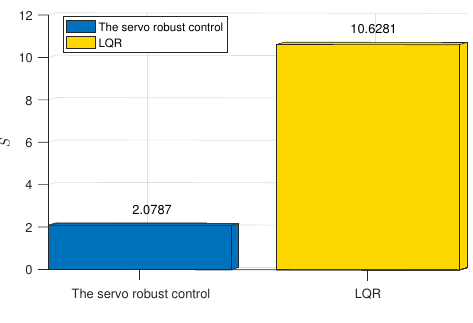
Figure 6. Comparison of the accumulative constraint error S .